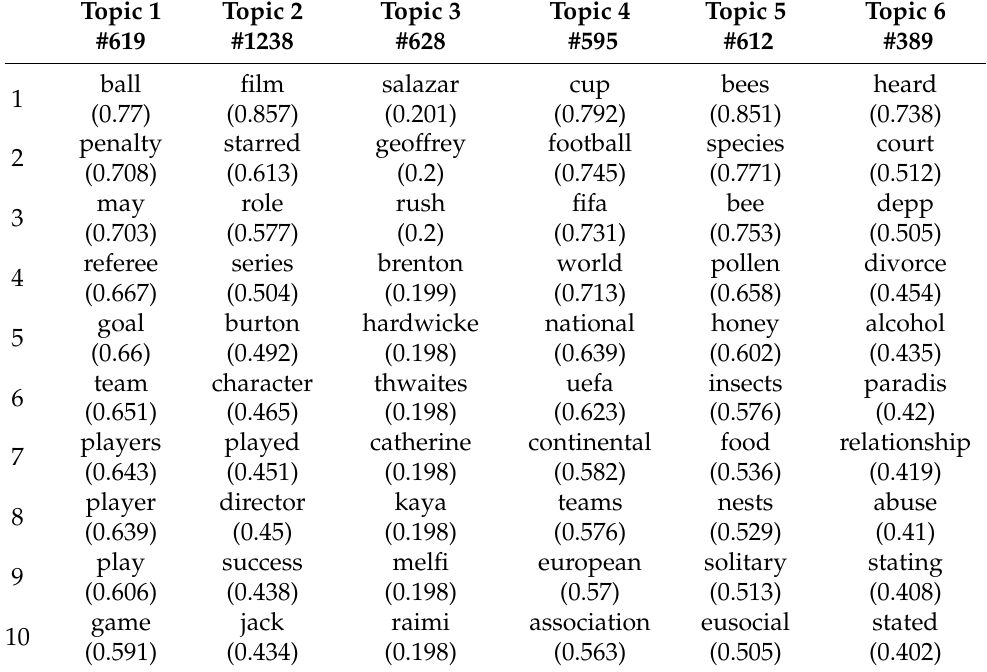
Table 5. The top 10 representative words per dimension of the basis matrix A (cid:48) , trained on the Wikipedia data as input matrix using automatic gradient